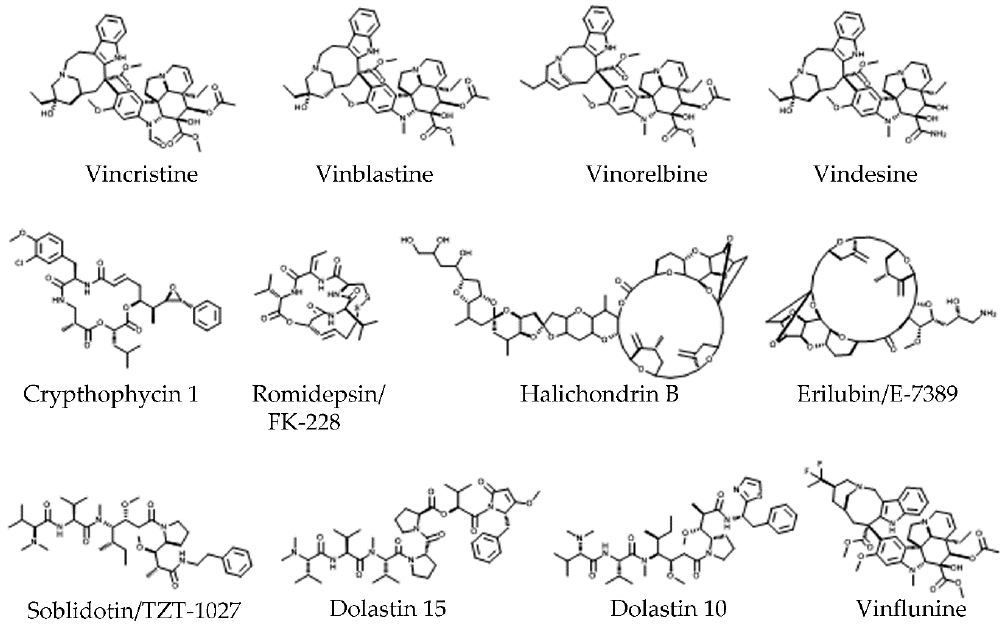
Figure 5. Structure of vincristine, vinblastine, vindesine, vinorelbine, vinflunine, dolastatin-10, dolastatin-15, TZT-1027, cryptophycin 1, FK228, halichondrin B, and E-7389.